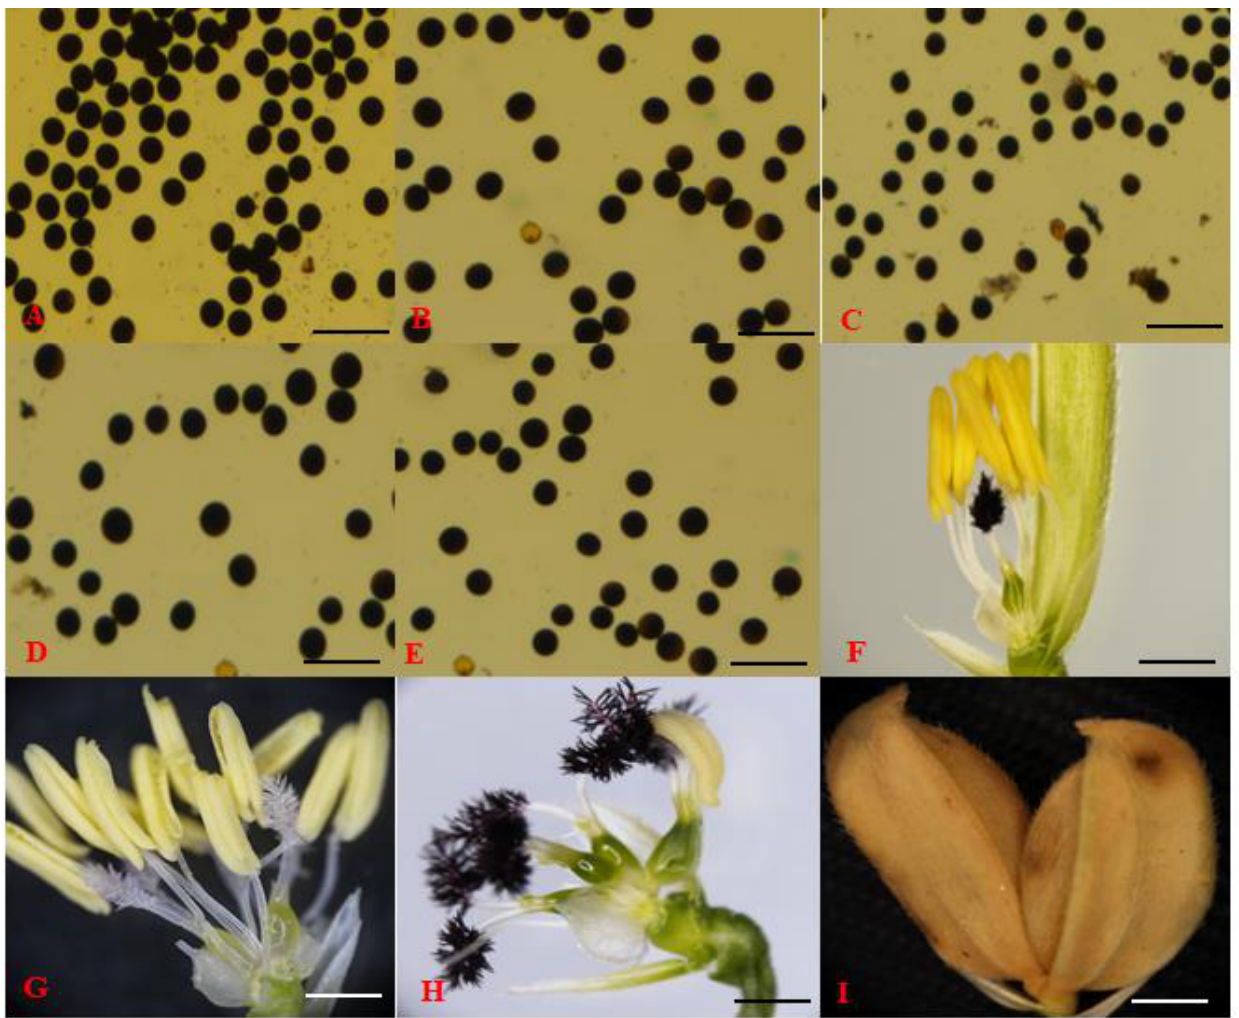
Figure 1. Phenotype of wild-type rice and mutant mp3. ( A – C ) Pollen fertility of wild-type rice. ( D , E ) Pollen fertility of mutant mp3 and 02428×mp3 F 1 individual. ( F ) Wild-type rice (XQZB) at heading stage. ( G , H ) Mutant mp3 at heading stage. ( I ) Twin seeds of mutant mp3 .